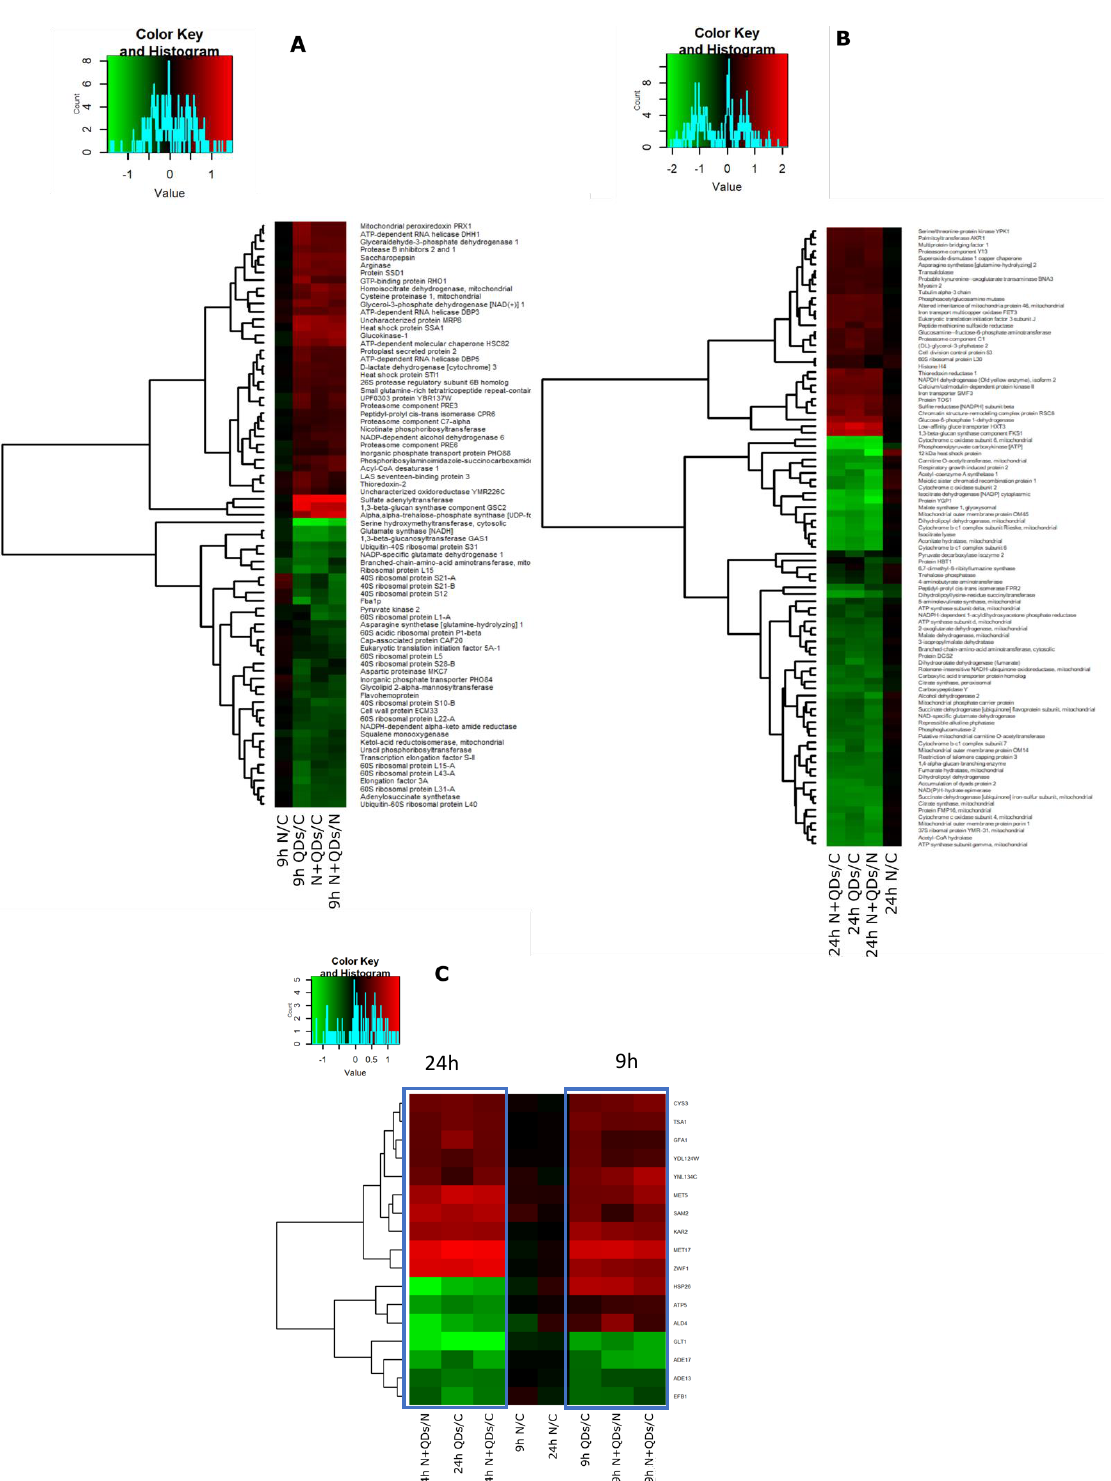
Figure 3. Heat map illustrating the relative abundance of the significantly enriched proteins ( A ) at 9 h; ( B ) at 24 h; ( C ) the common proteins between 9 and 24 h altered by treatment with CdS QDs found with